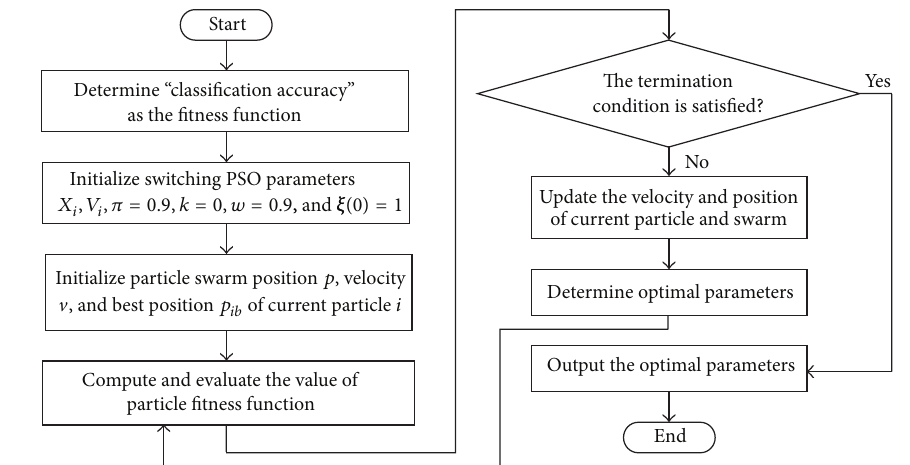
Figure 1: The flowchart of optimizing the parameters of SVM by the SPSO algorithm.